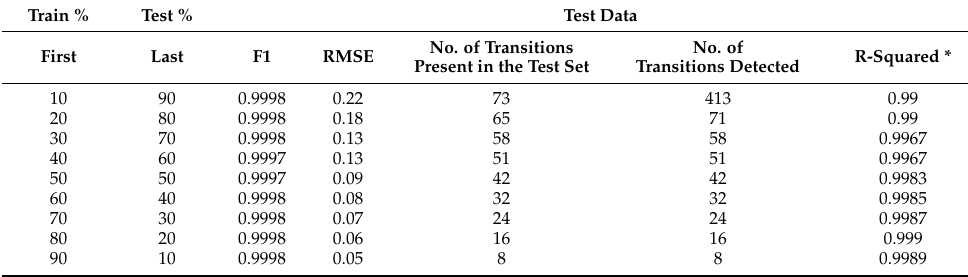
Table 8. Forecasting efficacy of the LSTM model for different training and testing partitions.